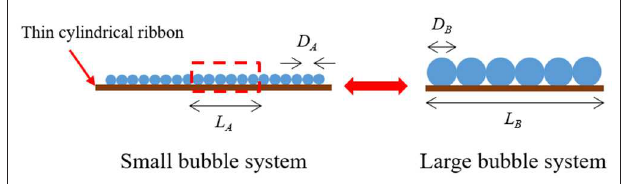
FIGURE 10 | Ideal configuration of bubble arrangement at CHF